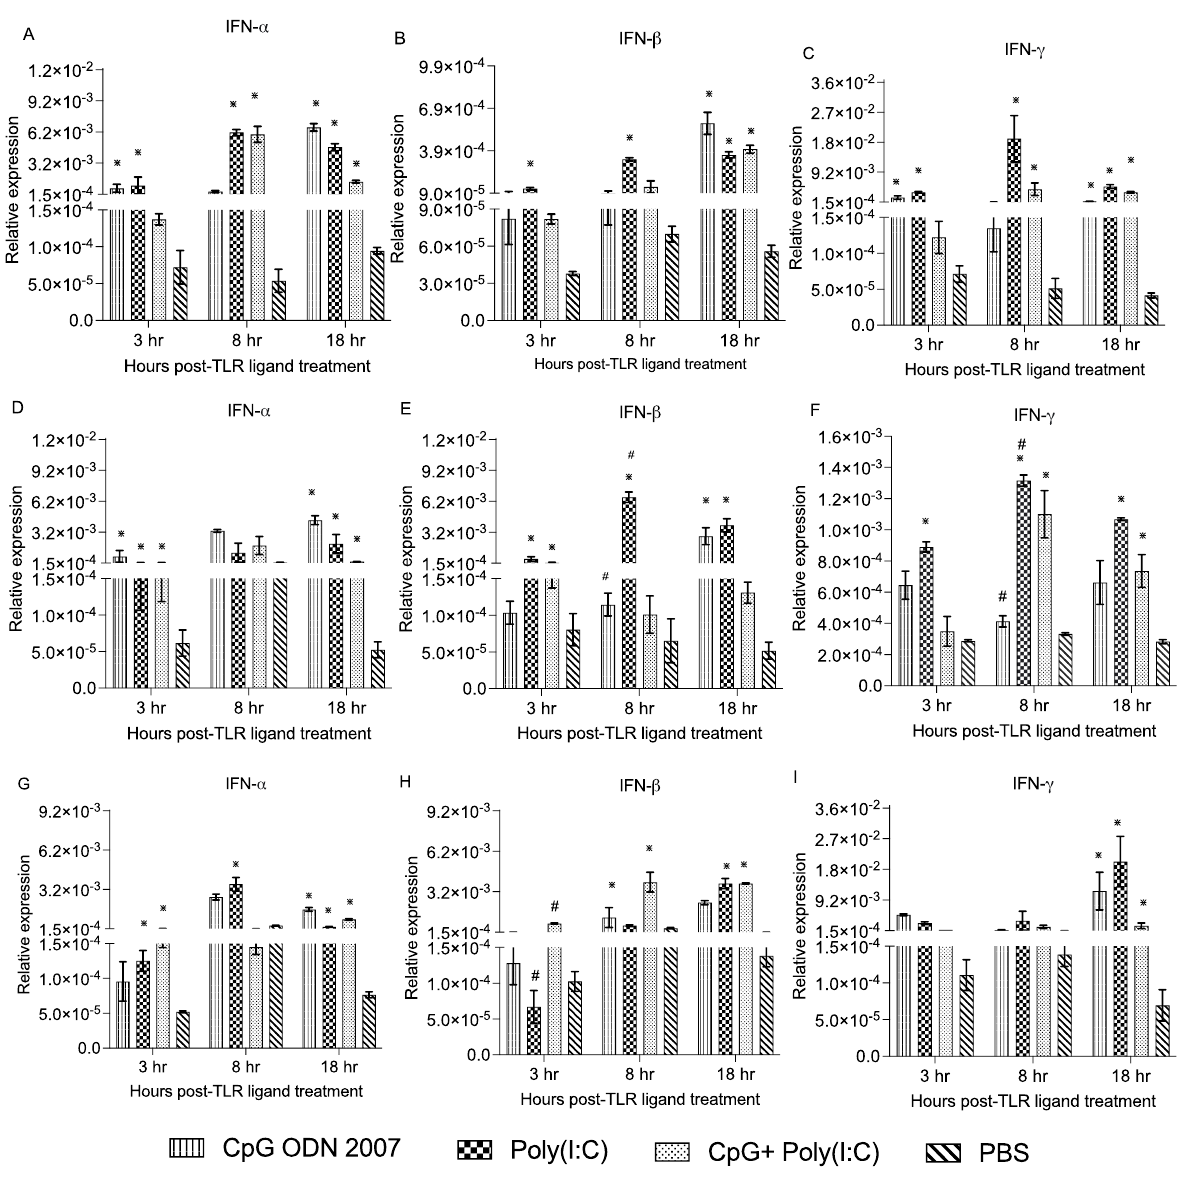
Figure 7. Relative gene expression of IFN-α, IFN-β and IFN-γ in the duodenum ( A – C ), jejunum ( D – F ) and ileum ( G – I ) at 3, 8 and 18 h post-CpG ODN 2007, poly(I:C) and combination treatment. Relative gene expression of IFN-α, IFN-β and IFN-γ at 3, 8 and 18 h post-TLR ligand treatment. Chickens were treated with CpG ODN 2007 (10 μg/chicken), poly(I:C) (400 μg/chicken) and a com- bination of CpG ODN 2007 (10 μg/chicken) + poly(I:C) (400 ug/chicken), or 100 μL PBS for the negative group. The plotted values represent the mean gene expression levels relative to B-actin ± standard error of the mean (SEM). Statistical significance was calculated using one-way ANOVA followed by Tukey’s multiple comparison test. The results were considered significant from PBS control p < 0.05